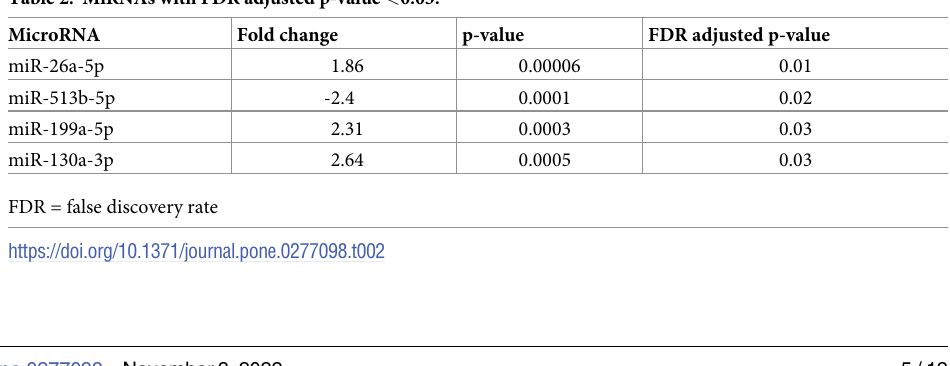
Values given as average ± standard